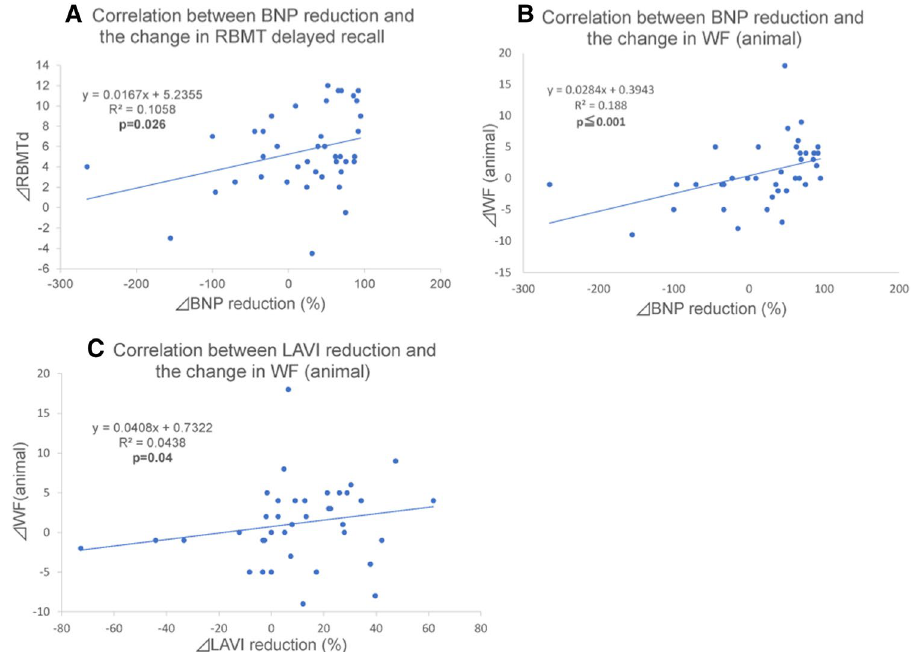
Figure 4. Correlation between cardiac function and neuropsychological findings (n = 40). There were positive correlations between LAVI (%) reduction and word fluency changes (animal) ( p = 0.04), between BNP (%) reduction and word fluency changes (animal) ( p ≤ 0.001), and between changes in BNP (%) and those in RBMT delayed recall ( p = 0.026). We calculated Spearman’s correlation coefficient. LAVI Left atrial volume